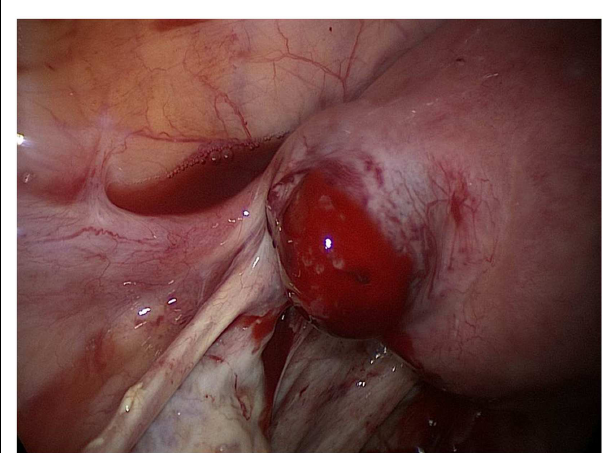
FIGURE 2 | Left interstitial pregnancy after ipsilateral salpingectomy (case 3).